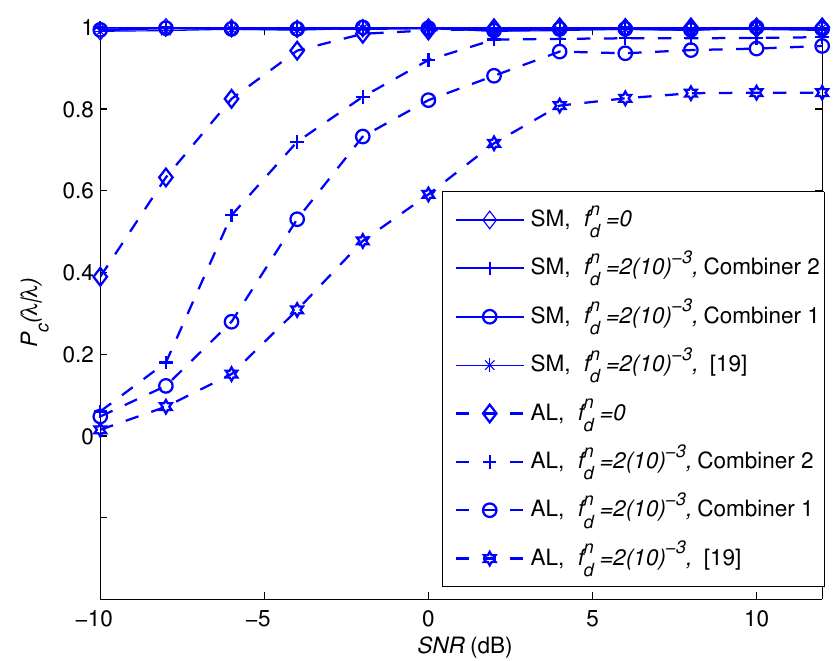
Figure 4. Probability of correct classification.